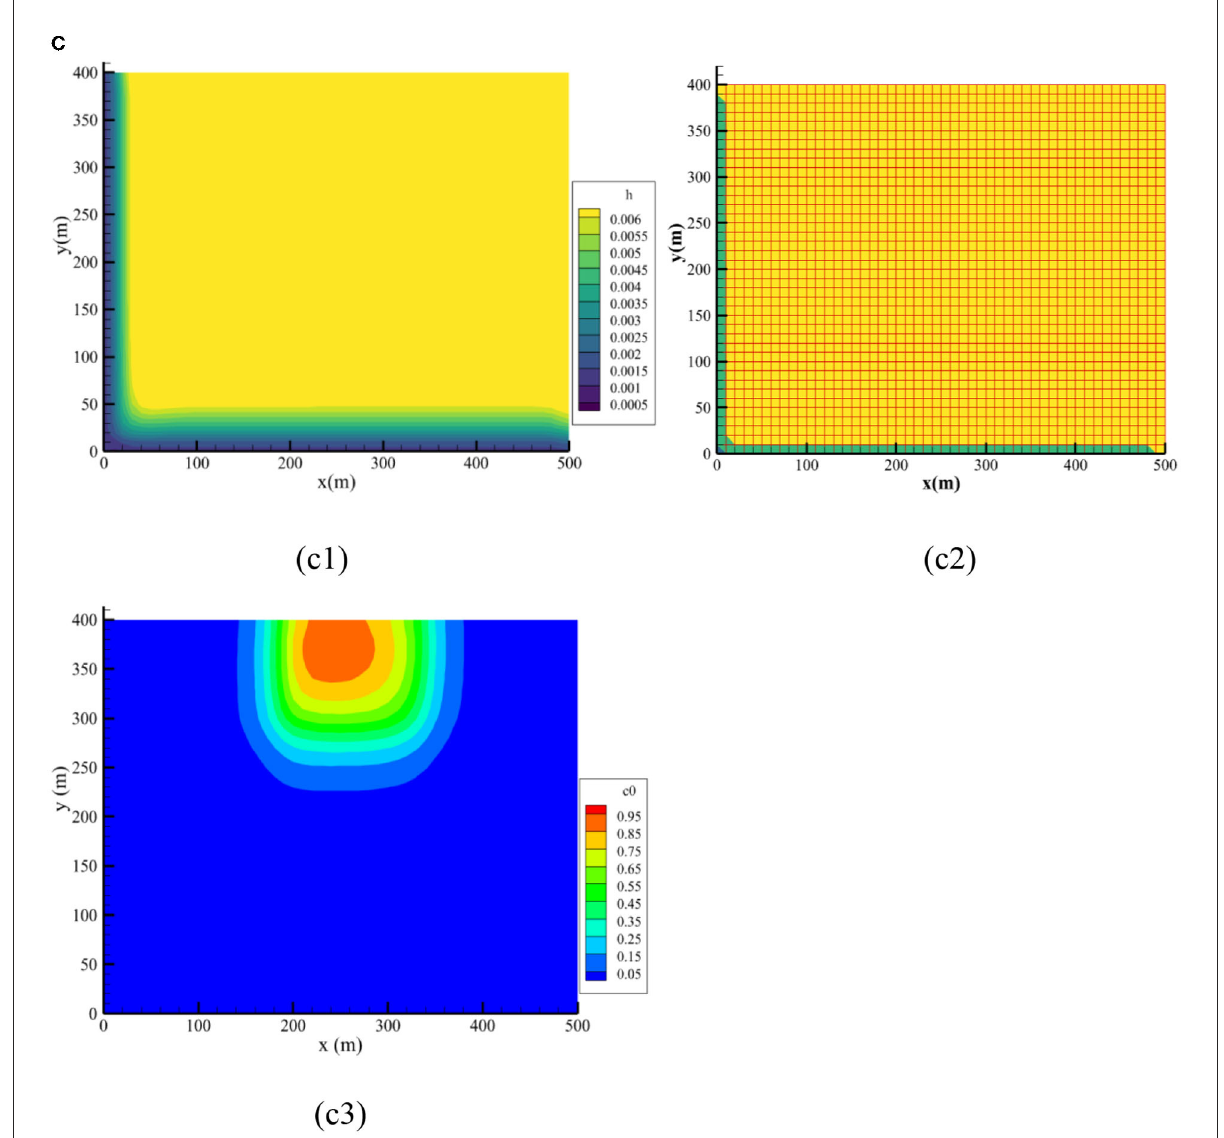
FIGURE9 Simulation results at different times. (A) t = 1,000 s : (a1) water depth (m), (a2) position of coupling boundary, and (a3) pollutant concentration (kg/m 3 ). (B) t = 3,500 s (b1) water depth (m), (b2) position of coupling boundary, and (b3) pollutant concentration (kg/m 3 ). (C) t = 6,000 s : (a1) water depth (m), (a2) position of coupling boundary, and (a3) pollutant concentration (kg/m 3